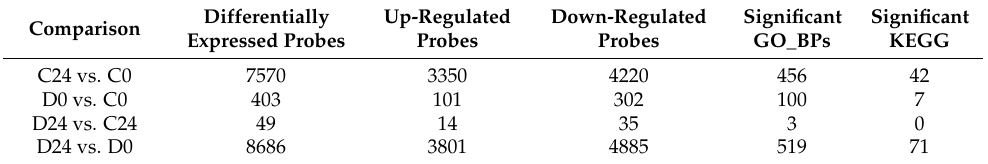
Table 1. Number of probes differentially regulated (FDR < 0.05) in each group comparison and their corresponding enriched Gene Ontology Biological Processes (GO_BPs) and KEGG pathways. All the differentially expressed probes in each comparison together with their p -value and fold change can be found in Table S2.